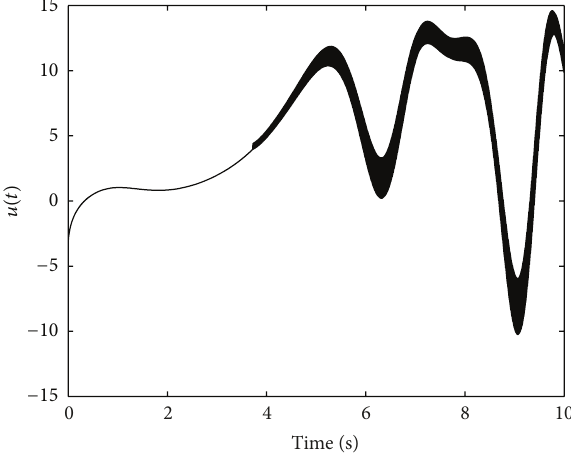
Figure 4: Time history of the control input